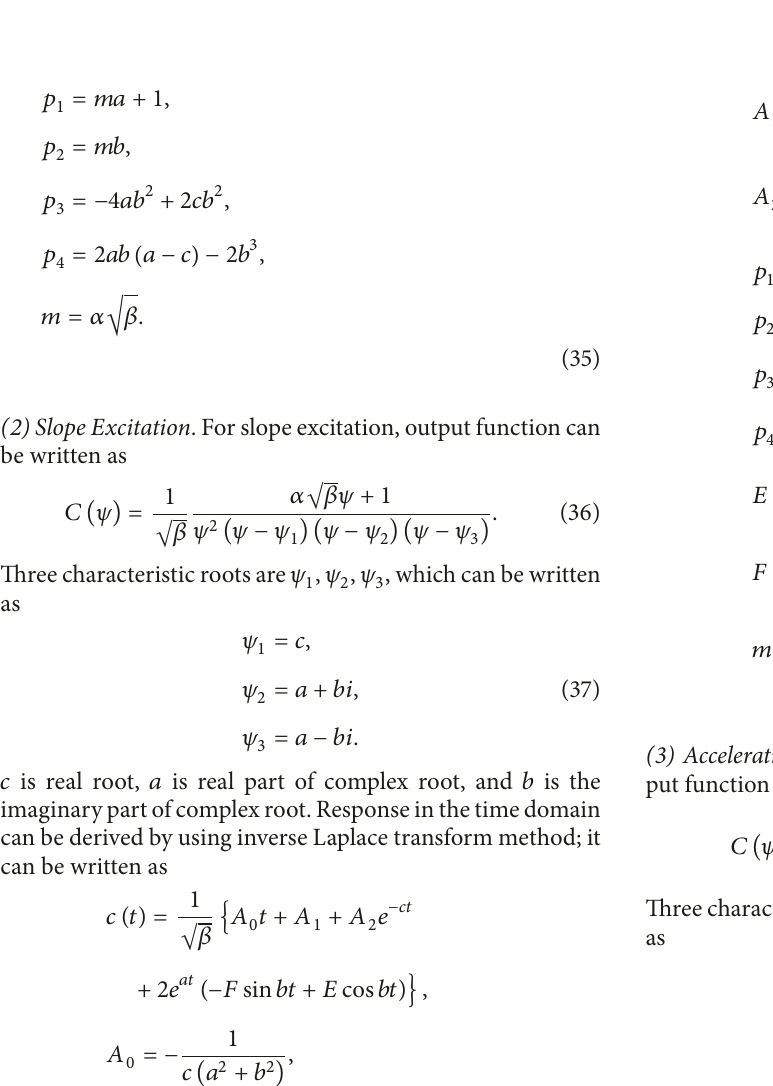
Figure 18: Amplitude-frequency characteristic and phase-fre- quency characteristic ( 𝛼 = 2, 𝛽 = 0.16, 1,6.25 ).